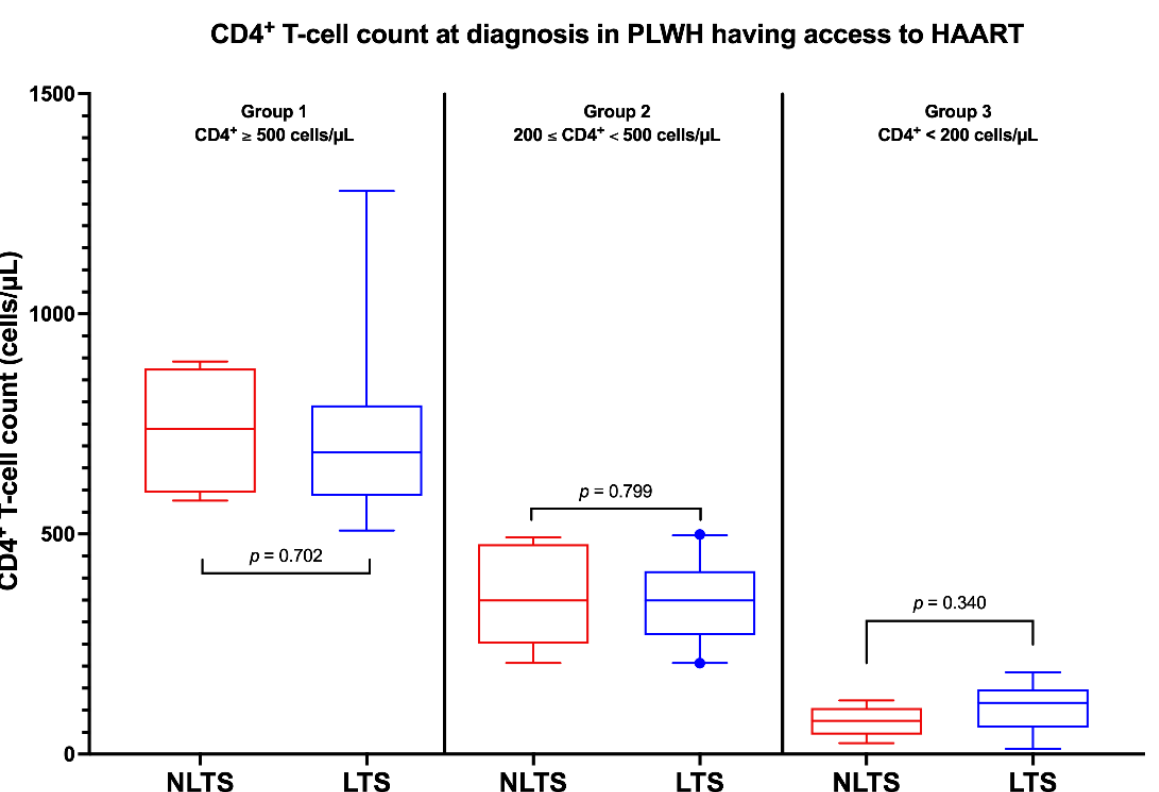
Figure 3. CD4+ T-cell count at diagnosis in People Living with HIV (PLWH) having access to Highly Active Anti-Retroviral Treatment (HAART). This figure shows that in PLWH who had access to HAART, CD4+ T-cell count was not significantly different between non-long-term survivors (red) and long-term survivors (blue), even when stratifying by CDC ’93 category. Whiskers represent the 95% CI. Abbreviations: PLWH—people living with HIV; HAART—highly active antiretroviral ther- apy; NLTS—non-long-term survivors; LTS—long-term survivors.